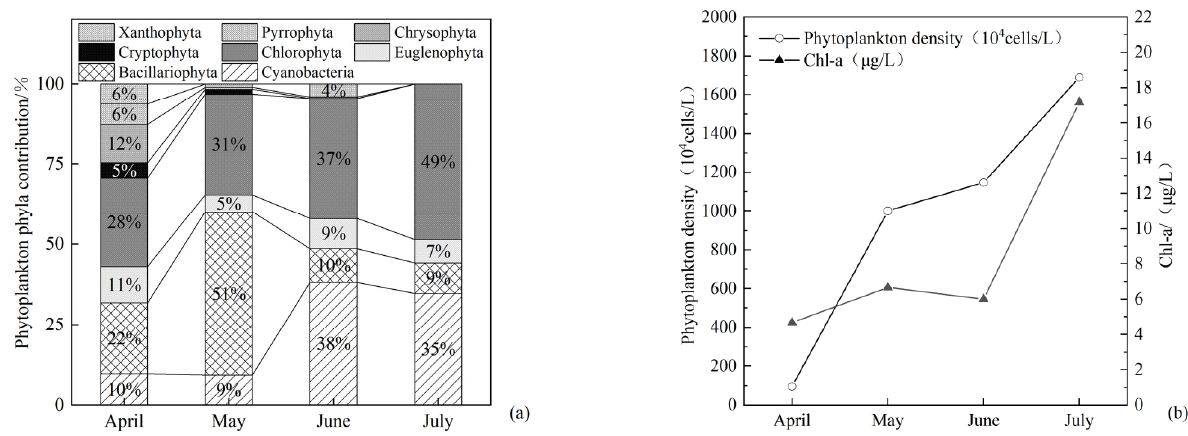
Figure 4. Monthly proportion of phytoplankton phyla ( a ) and monthly variation diagram of phyto- plankton density and Chl-a ( b ).